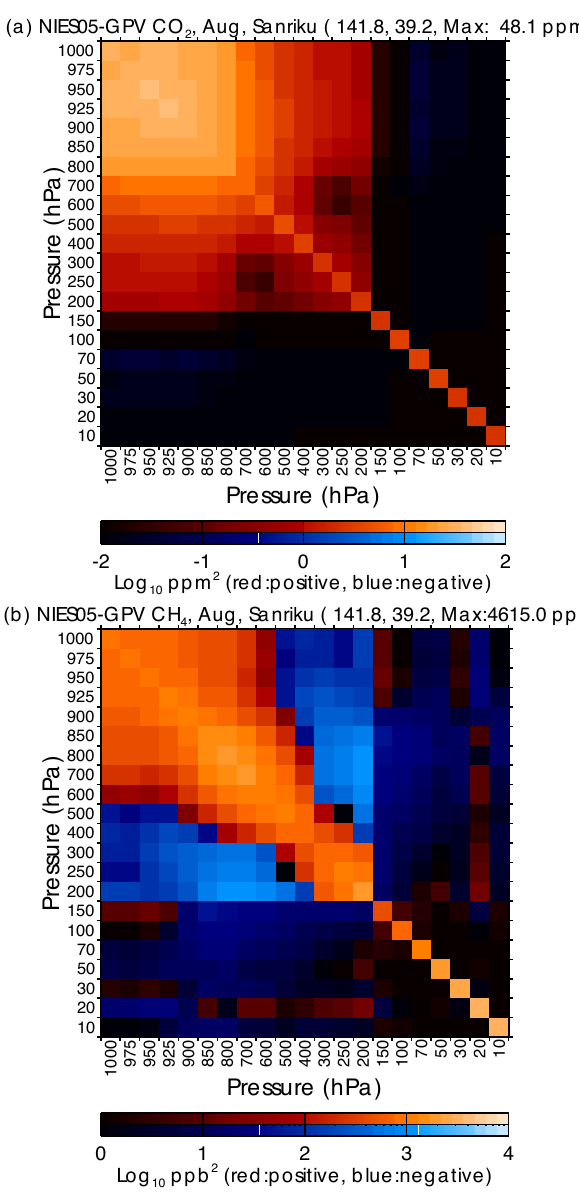
Fig. 1. A priori error variance–covariance matrices of (a) CO 2 and (b) CH 4 over Sanriku, Japan (39.2 ◦ N, 141.8 ◦ E) in August at 21 pressure levels from 1000 to 10hPa. Colour scales are logarith- mic, with ranges of 0.01–100ppm 2 for CO 2 and 1–10000ppb 2 for CH 4 . Warm and cold colours indicate positive and negative correla- tions, respectively. Dark and light colours indicate small and large variance–covariance values, respectively.